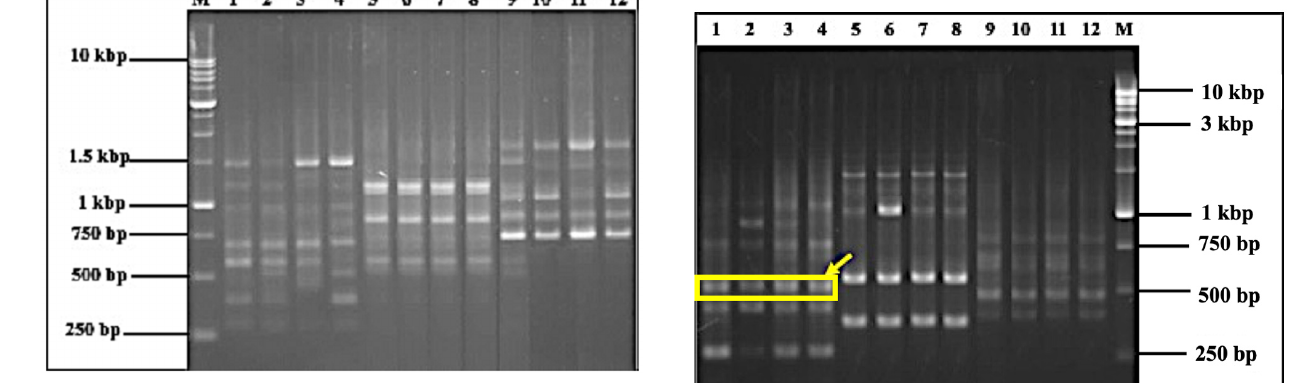
Figure 2. RAPD fingerprint results from amplification of DNA samples using primers OPU 08 on 1.2% agarose gel. Lanes 1 and 2 are biological samples of C. kaliana (YKH004 and YKH020) while lanes 3 and 4 are technical replicates of YKH004 and YKH020 respectively; lane 5 is a biological sample of C. stenochila (YKH031) while lanes 6 to 8 are technical replicates of YKH031; lane 9 is a biological sample of C. tiomanensis (FRI75329) while lanes 10 to 12 are technical replicates of FRI75329. Lane M represents the 1.0 kb DNA ladder (Promega, USA). Fragments indicated by arrows were the specific bands, which were selected and subsequently sequenced for SCAR marker primer pair design.